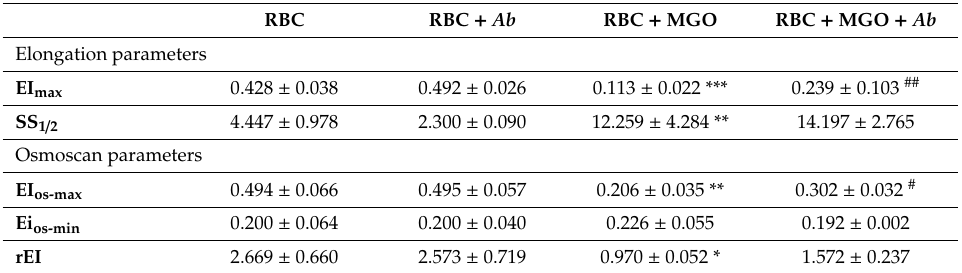
Table 6. Antirhea borbonica prevents MGO-induced impairments in red blood cell